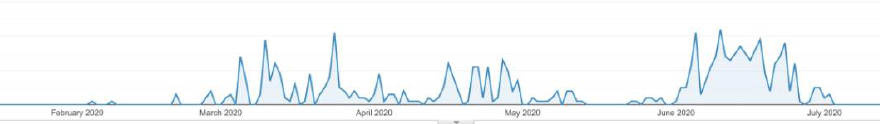
Fig. 7b. Dynamics of visits to the Theorem on the estimation of an integral.